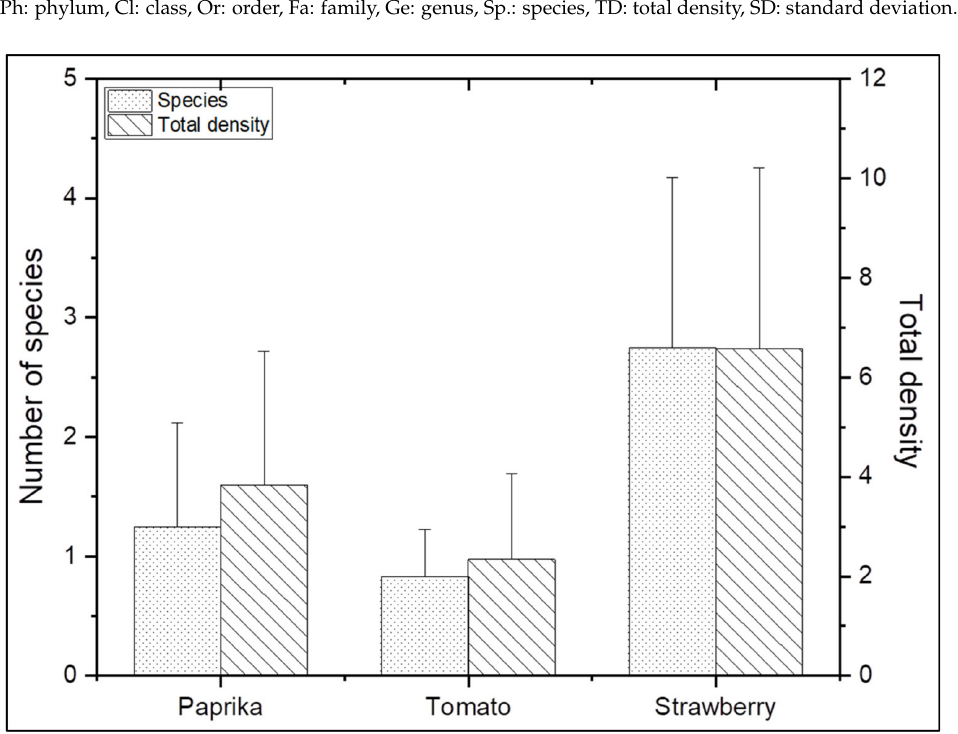
Figure 5. Average density of bacteria detected at 36 study sites according to cultivated